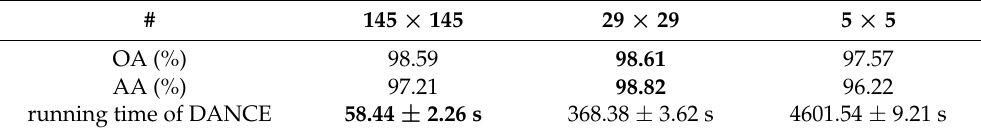
Table 10. Comparison of the different sub-block sizes on the Indian Pines data.